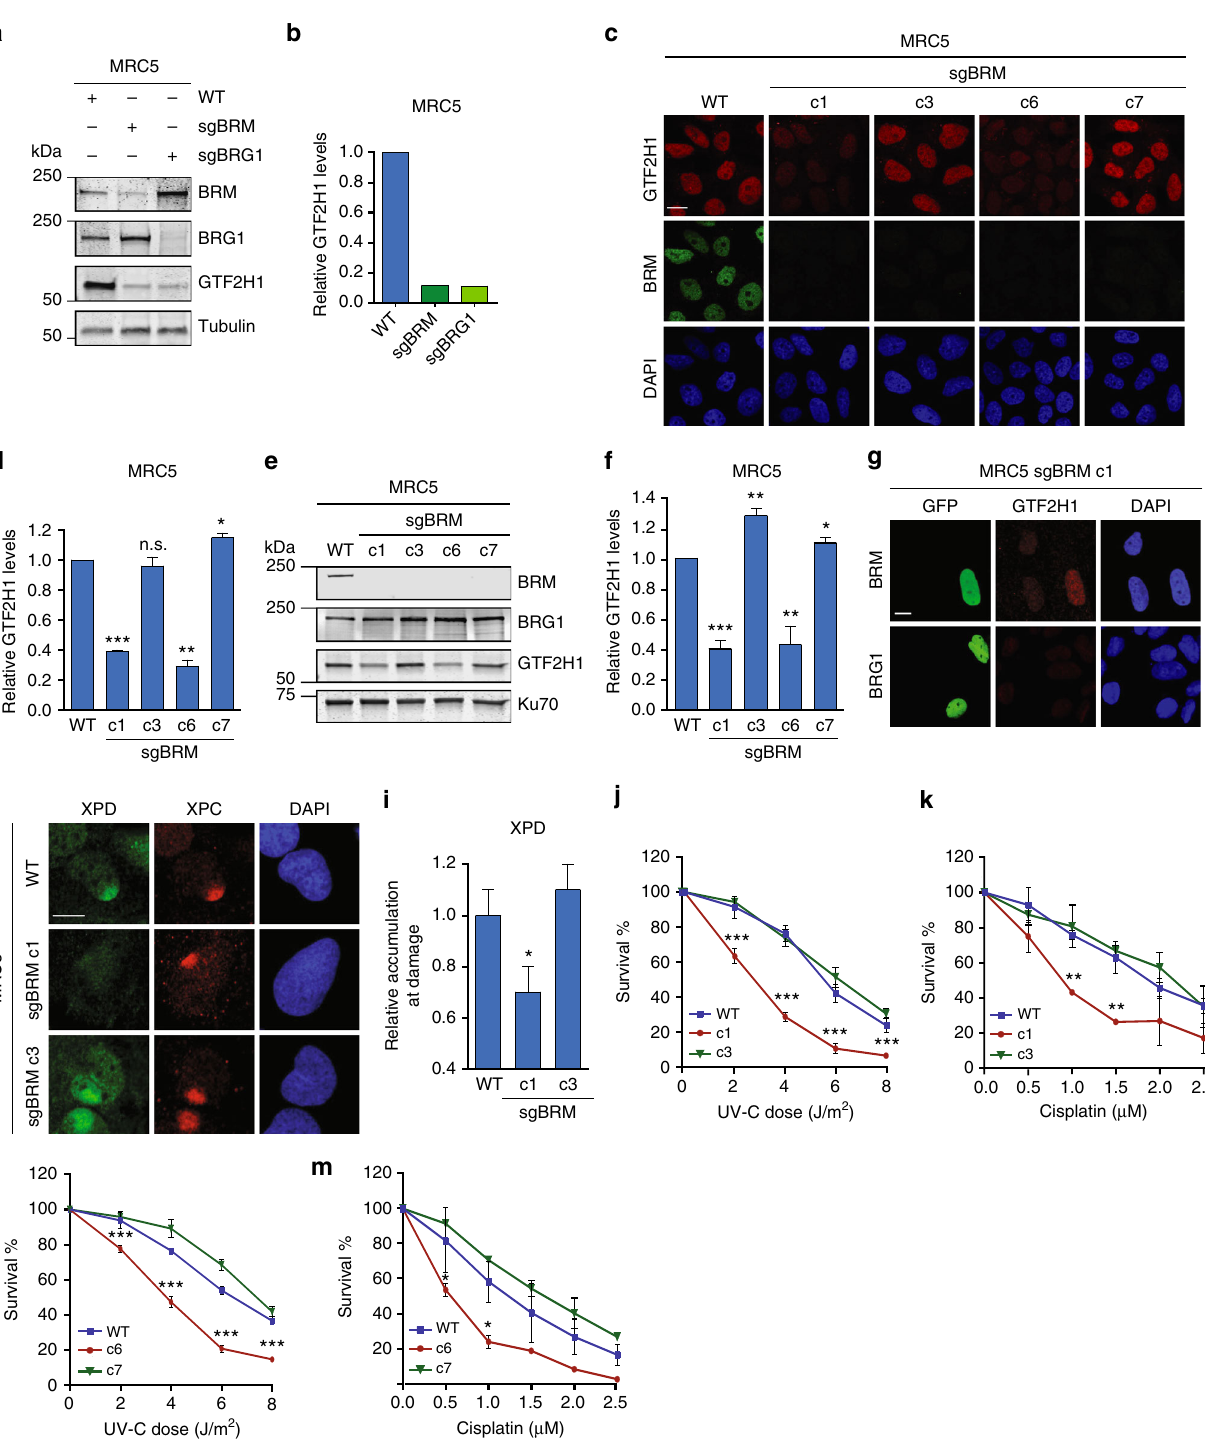
Furthermore, we did not observe BRM and BRG1 recruitment to UV-damaged DNA, further corroborating that SWI/SNF ’ s main involvement in the UV-DDR is not in the control of chromatin accessibility at sites of UV damage. SWI/SNF complexes are thought to be recruited to chromatin to remodel nucleosomes in enhancer and promoter regions to regulate transcription 7,46 . In line with this, we observed in two different cell types that BRM and BRG1 ChIP-seq signals are enriched at the GTF2H1 promoter. SWI/SNF ’ s in fl uence on